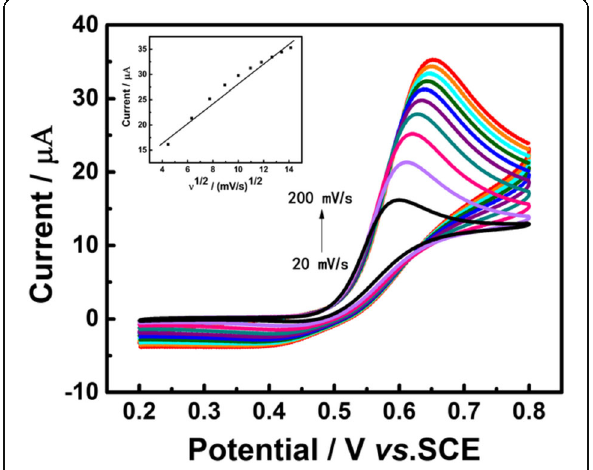
Fig. 6 CVs of the Au/GCE in 0.1 M PBS (pH = 7.0) solution containing 1 mM UA at scan rates ranging from 20 to 200 mV s − 1 . Inset : calibration curve of peak current vs. v